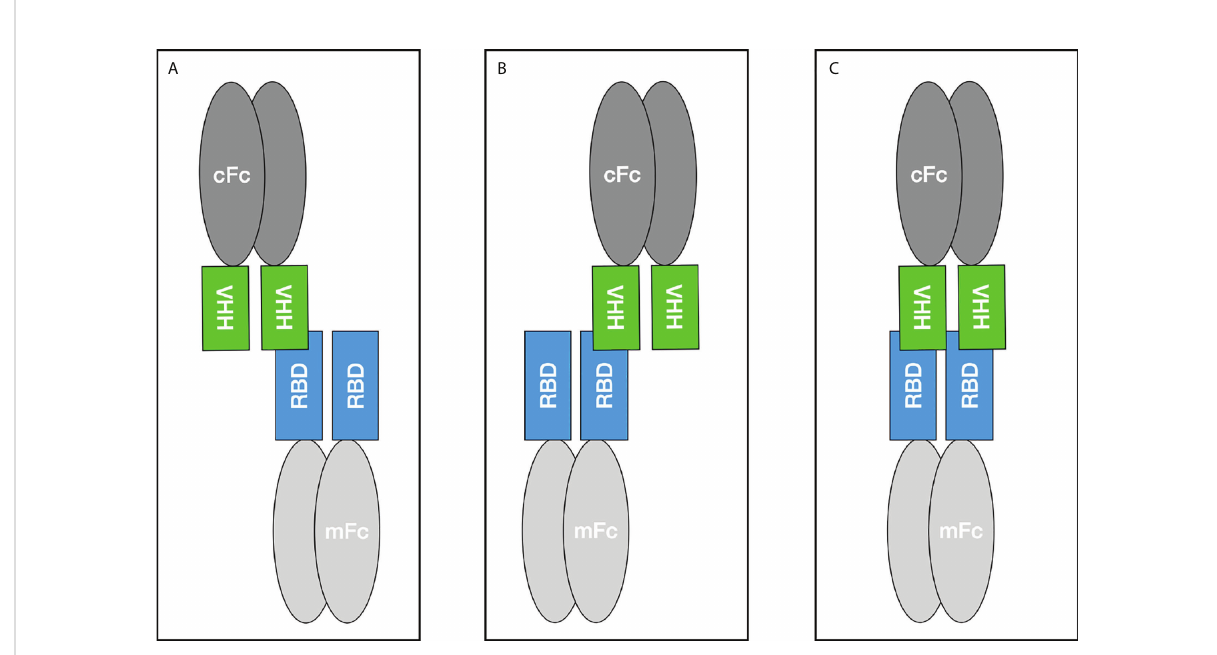
FIGURE 7 Binding scenarios for the Fc-tagged VHH construct and the SARS-CoV-2 RBD domain fused to a murine Fc tag during SPR measurements. mFc - murine Fc, cFc - camelid